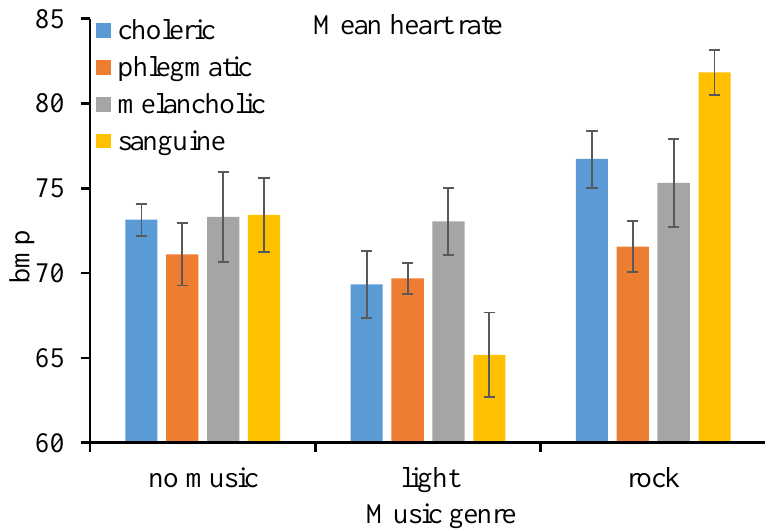
Figure 2. Mean heart rate (and standard error) by music genre and personality.